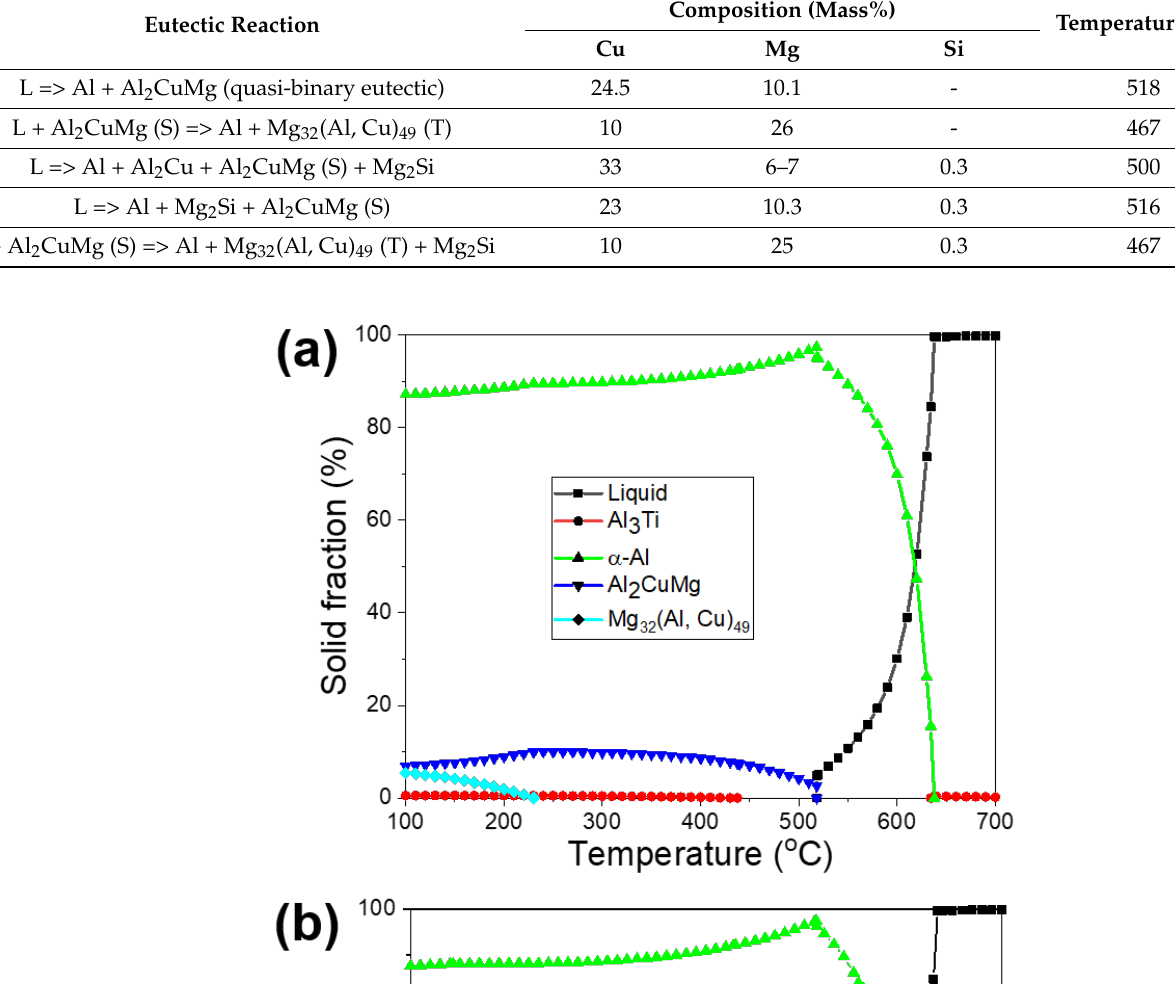
Table 2. Non-variant reactions that are formed at the Al-rich corner of the Al–Cu–Mg-Si quaternary phase diagram, as documented in reference [2]. Table 2. Non - variant reactions that are formed at the Al - rich corner of the Al – Cu – Mg - Si quaternary phase diagram, as documented in reference [2].